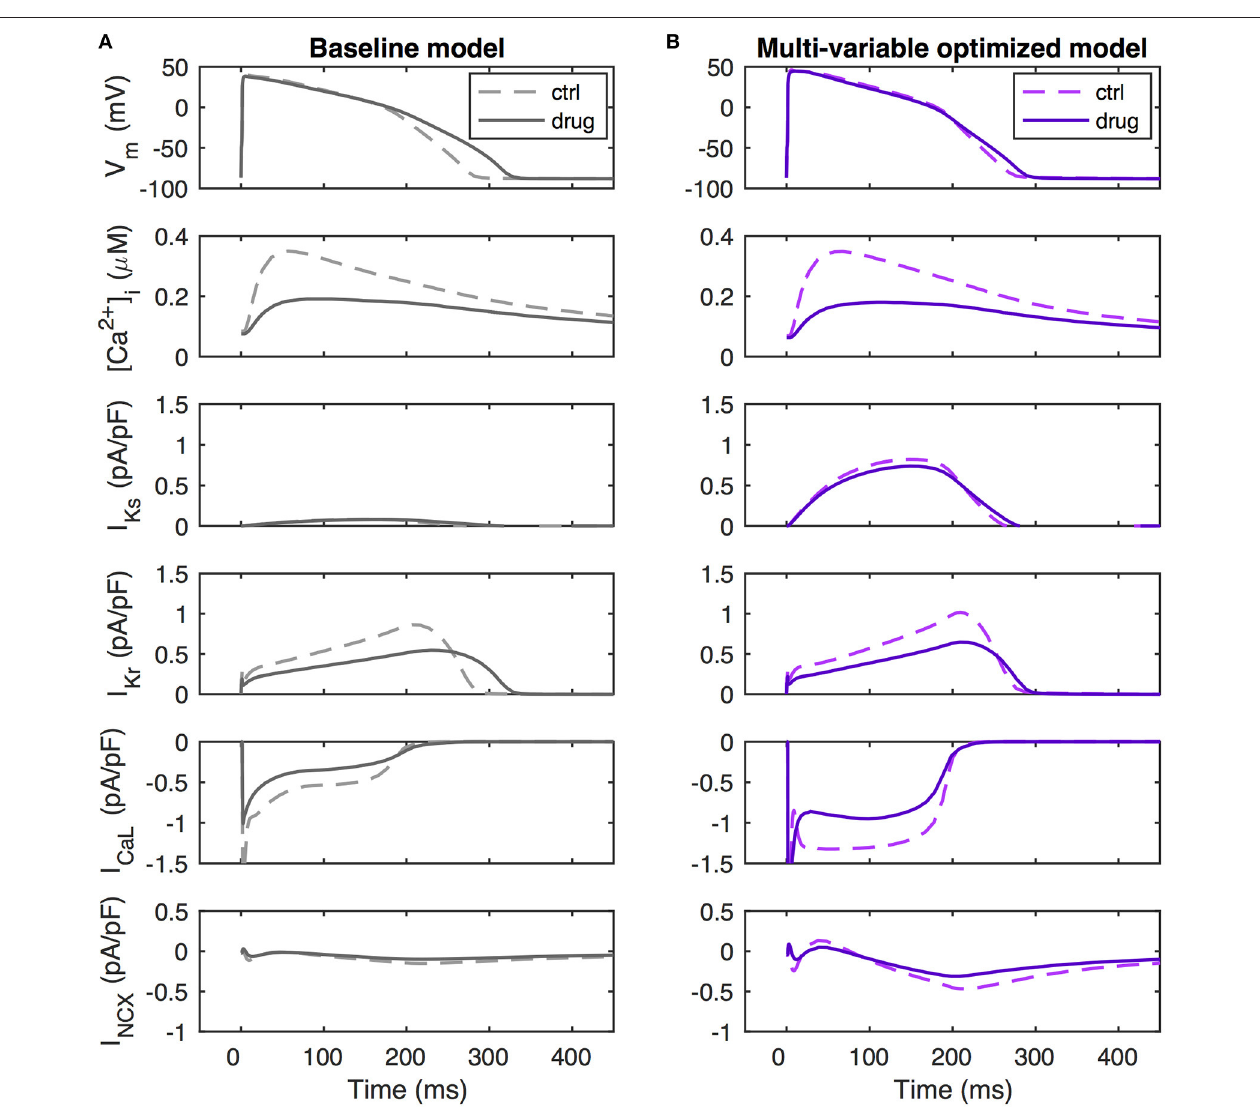
FIGURE 5 | Ionic mechanisms of repolarization dynamics during verapamil application. (A) Baseline model. (B) Multi-variable optimized model. Verapamil (simulated as a scaling of G CaL by 0.64, a scaling of G Kr by 0.55, and a scaling of G Na by 0.998) decrease I Kr by similar amounts in the baseline and in the multi-variable optimized models. However, due to the up-regulated I CaL and I NCX in the optimized model, it sustains a larger loss of inward current than the baseline model. Further,